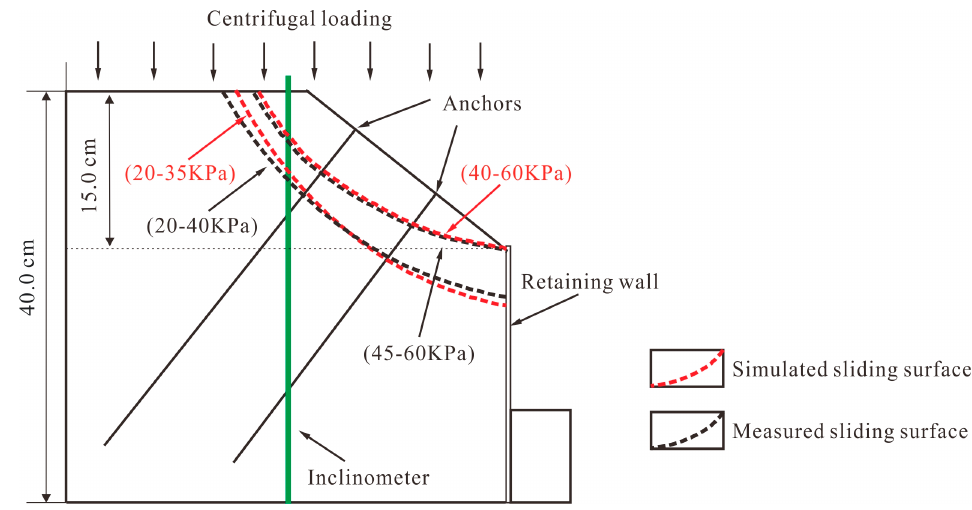
Figure 13. Slope failure mode under different centrifugal force.